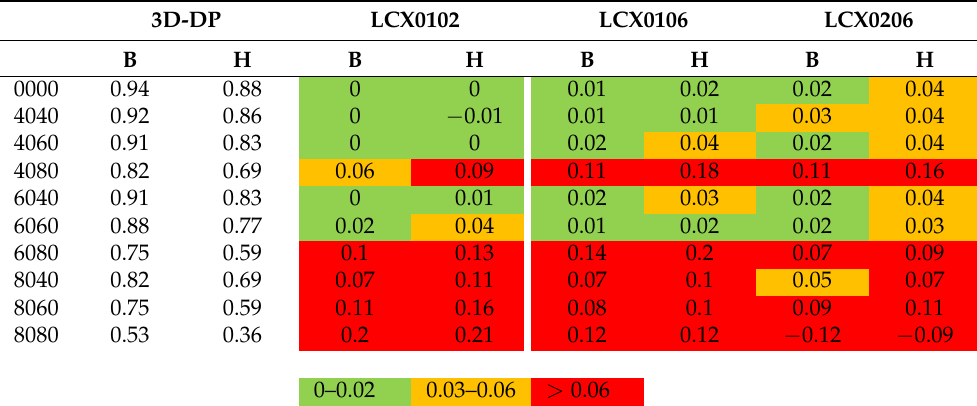
Table 4. Virtual FFR values at baseline (B) and hyperaemia (H) for the left circumflex (LCX) model and the original digital phantom (DP), the reconstruction using views 1 and 2 (LCX0102), 1 and 6 (LCX0106), and finally, 2 and 6